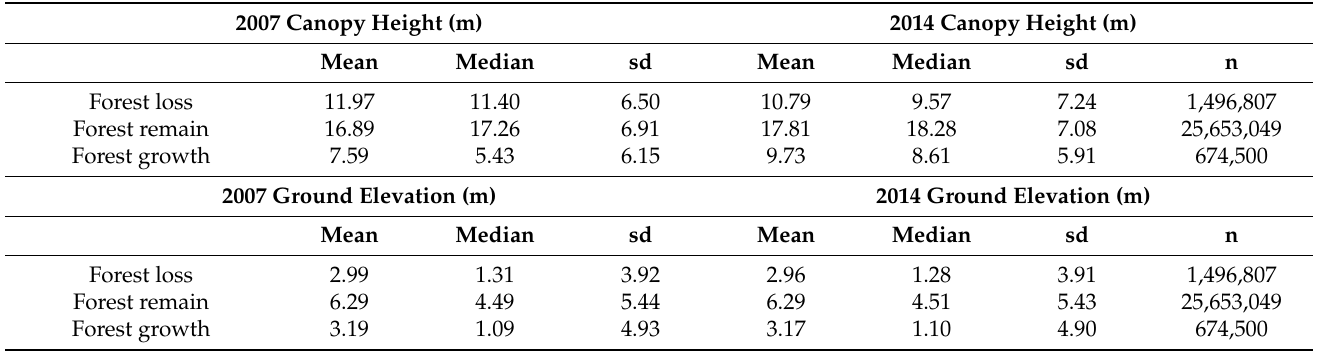
Table 4. Summary statistics of multi-temporal canopy height and ground elevation among the change